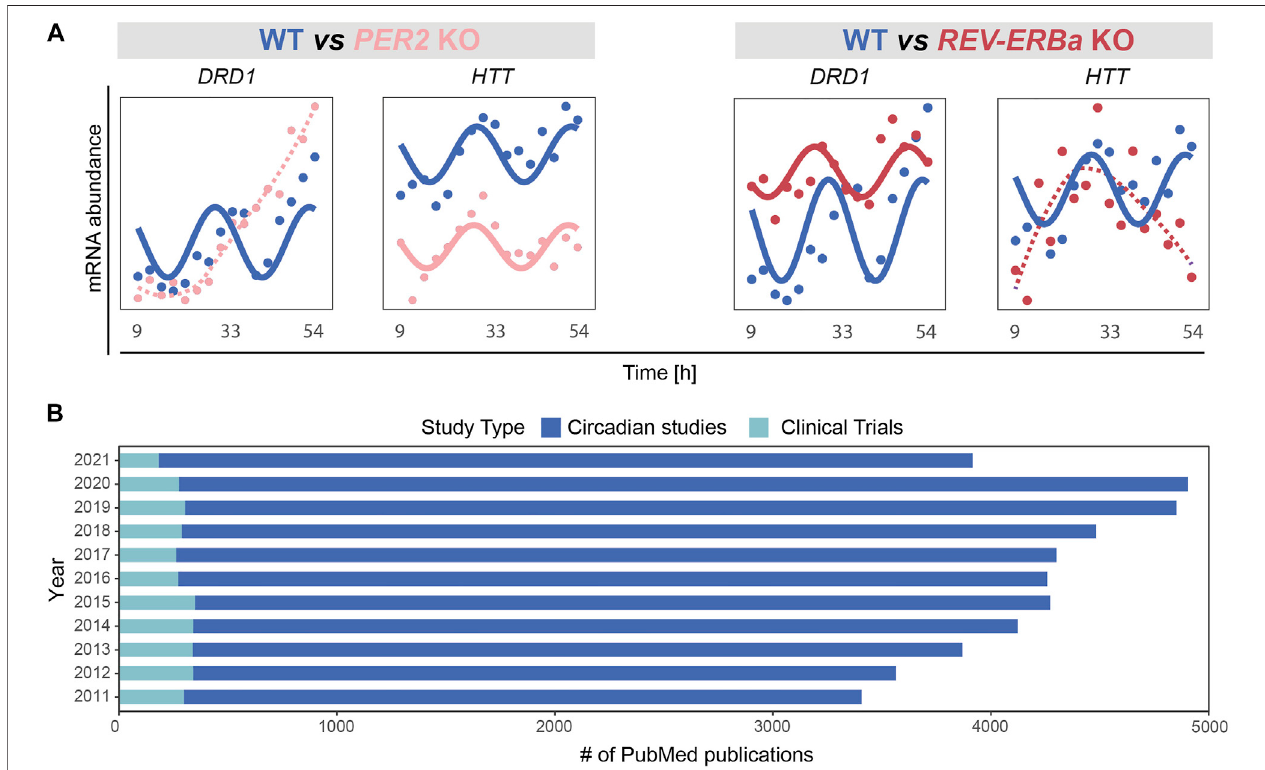
FIGURE 3 | Emerging role ofthe circadian clock in regulation of disease associated mechanisms and its applications in basicvs. clinical research. (A) Perturbation of core-clock genes in an in vitro CRC model (HCT116 wild type (WT) and their derived PER2 and REV-ERB α knockout (KO) cells, ArrayExpress: E-MTAB-9701 (Yalcin et al., 2021)) may result in complete abolishment of circadian rhythmicity and/or alteration of oscillatory properties (amplitudes or phases), as observed for DRD1 , and HTT . (B) Number of PubMed publications in last 10 years. Studies were categorized based on research type: circadian (studies with basic research) and clinical (studies including circadian biology in a clinical study